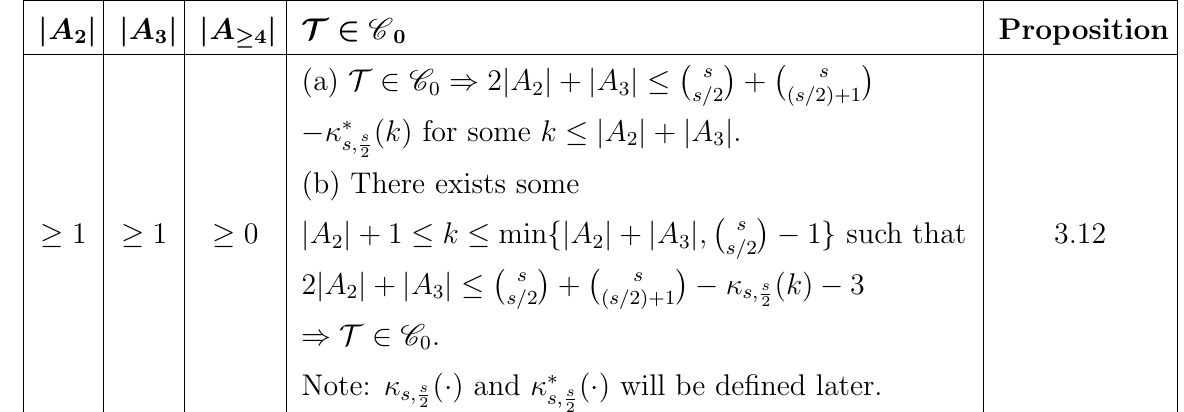
( s , s , . . . , s ), where s ≥ 4 is even. 4 1 2 n